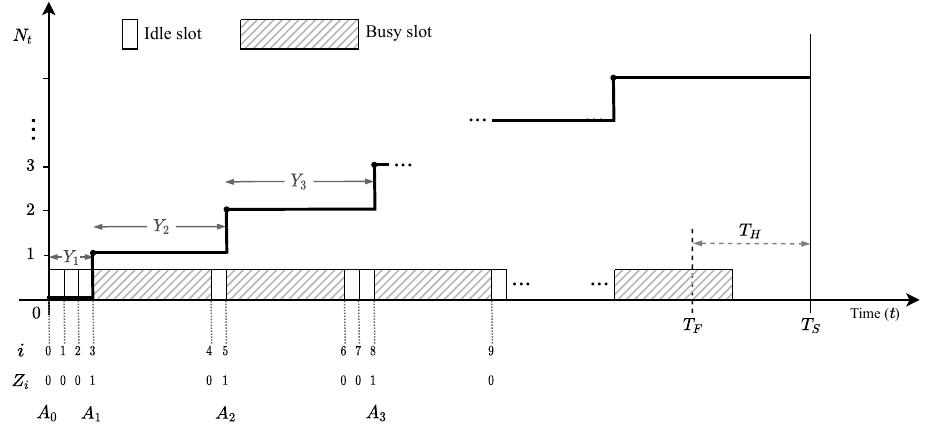
Figure 5. Illustration of the stochastic